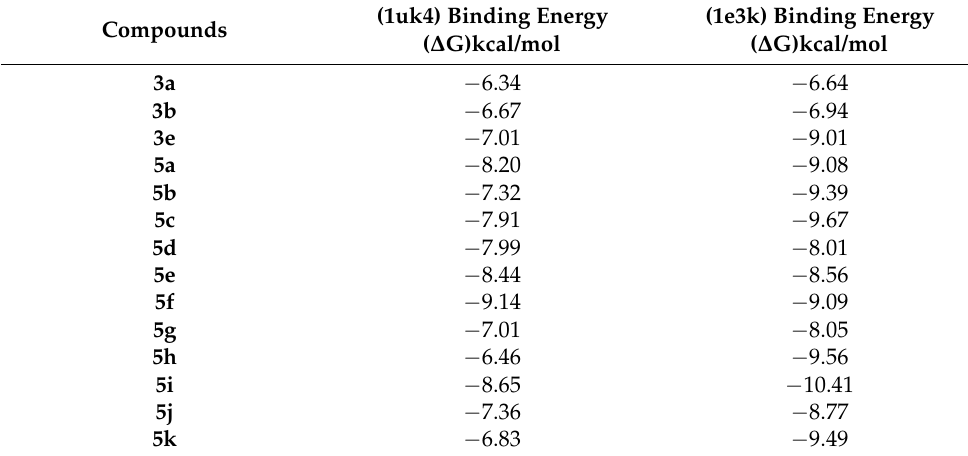
Table 1. Binding energies produced from molecular docking for all studied compound with ( 1uk4 ) and ( 1e3k ).